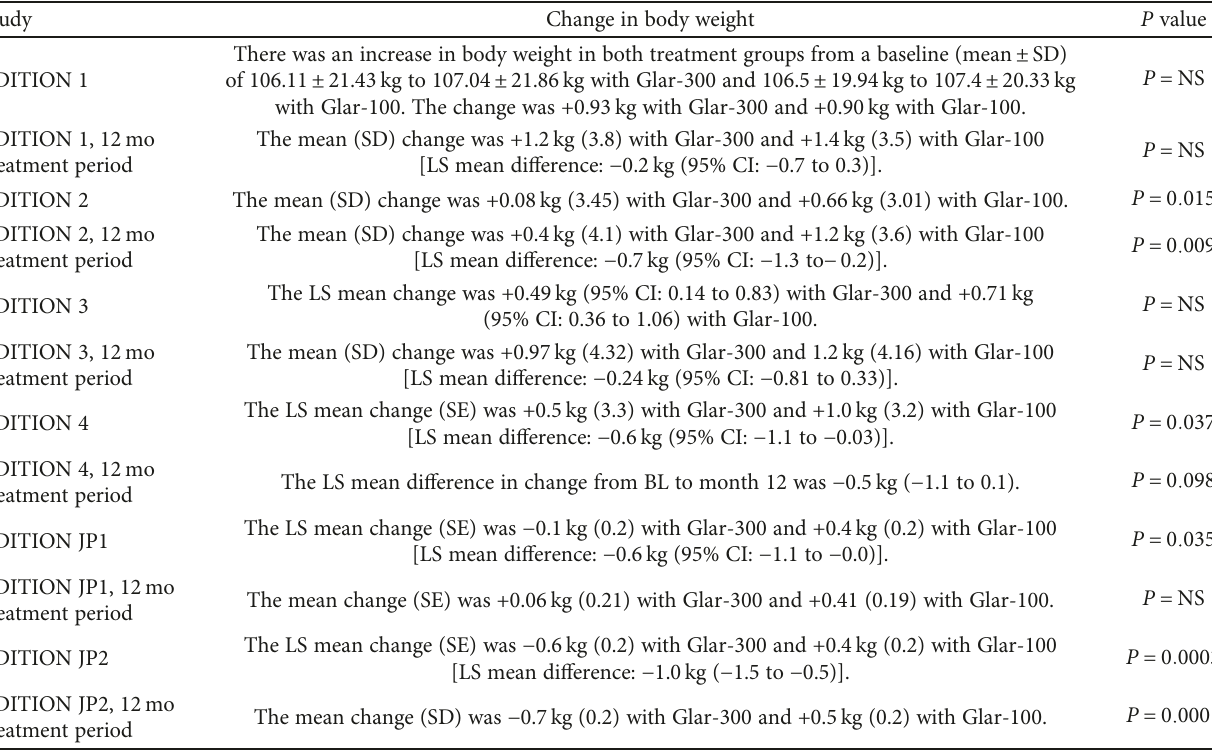
Table 5: Change in weight for Glar-300 versus Glar-100 across the EDITION phase 3 clinical trial program. Study Change in body weight P value EDITION